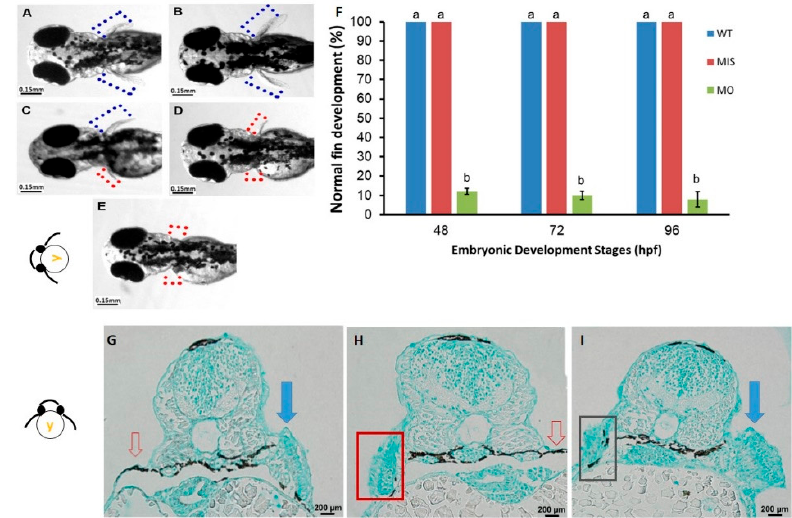
Figure 1. Phenotypes of pectoral fins in tbx5a -deficient embryos. Wild-type embryos with bilateral normal development of the pectoral fin ( A , B ). Unilateral hypoplasia ( C ), unilateral agenesis ( D ), and bilateral agenesis ( E ) of the pectoral fin in tbx5a morphants at 96 hpf. The rate of normal fin development was significantly reduced in tbx5a -deficient embryos at 48, 72, and 96 hpf ( F ). a, b: A significant difference was detected by one-way ANOVA with Duncan’s multiple range test. WT: Uninjected group, MIS: Control MO-injected group, MO: tbx5a morphant group. ( G ) Cross section of embryos with morphologic unilateral agenesis of the pectoral fin with Alcian blue staining showing well-organized glycosaminoglycans (GAGs) in the normal pectoral fin (blue arrow) with complete absence of chondrocytes and GAGs at the aplasia site (red arrow). ( H ) Cross section of the embryo with morphologic bilateral hypoplasia/agenesis of the pectoral fin showing the absence of chondrocytes and GAGs at the aplasia site (red arrow) with disorganized GAGs in the hypoplastic pectoral fin (red box). ( I ) Cross section of the embryo with morphologic unilateral hypoplasia of the pectoral fin showing disorganized GAGs in the hypoplastic pectoral fin (black box) and well-organized GAGs in the normal pectoral fin (blue arrow).